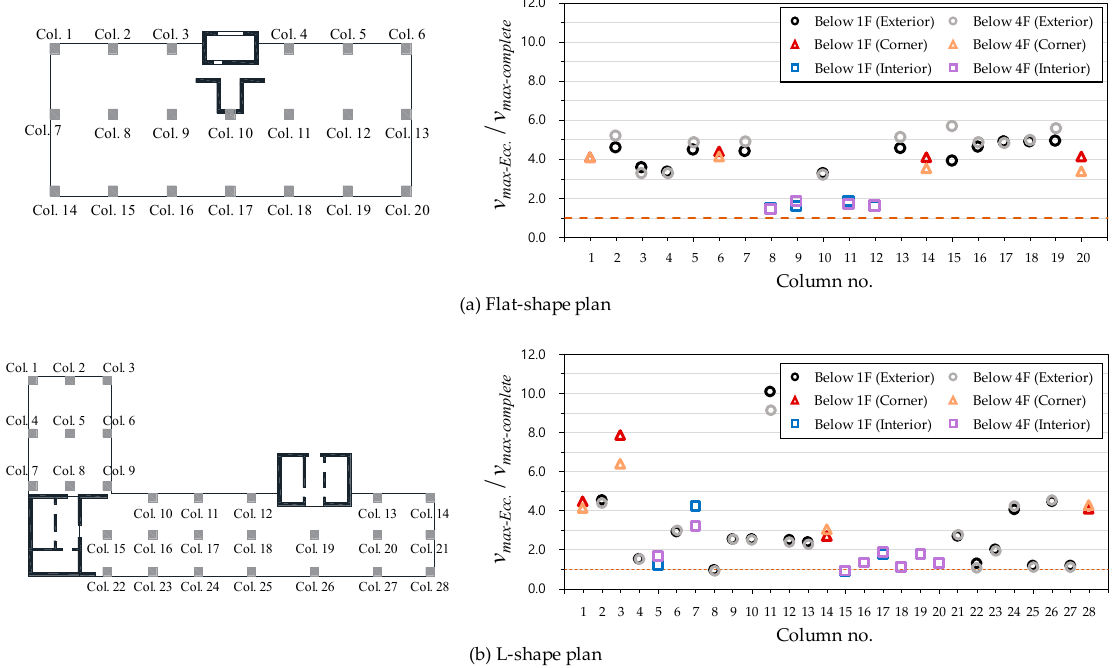
Figure 15. Maximum punching shear stress ratio according to number of stories below transfer plate (for gravity load only). ( a ) Flat-shape plan and ( b ) L-shape.